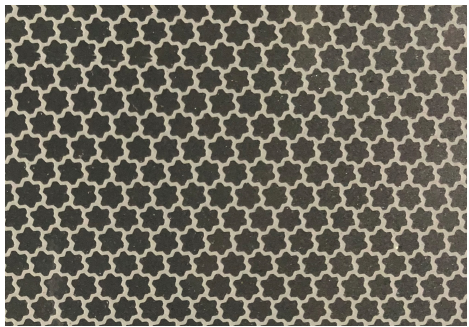
Figure 1. Close-up photograph of a glass bead type material.